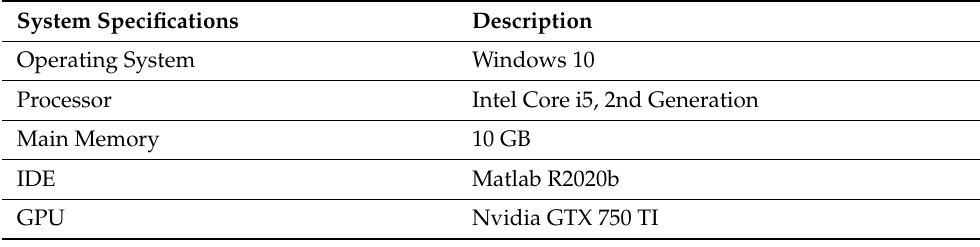
Table 2. Implementation environment for the proposed multi-scale CNN